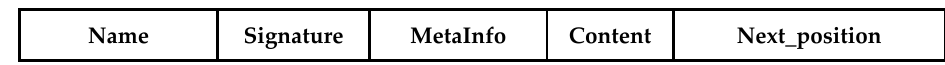
Figure 4. Control fields of Interest packets.